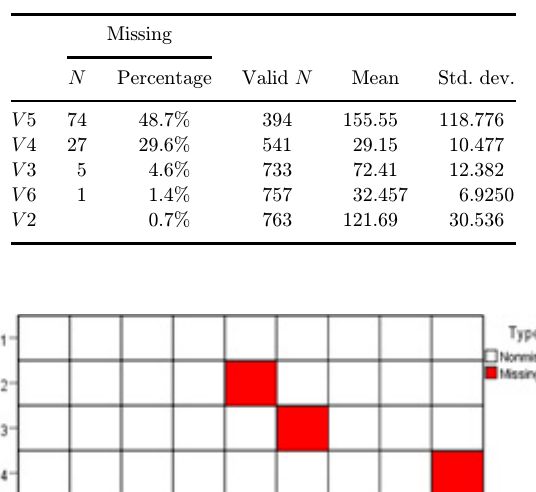
Table 1. Distribution of missing values among the features with incomplete data in the instances of the Pima Indians Diabetes dataset.